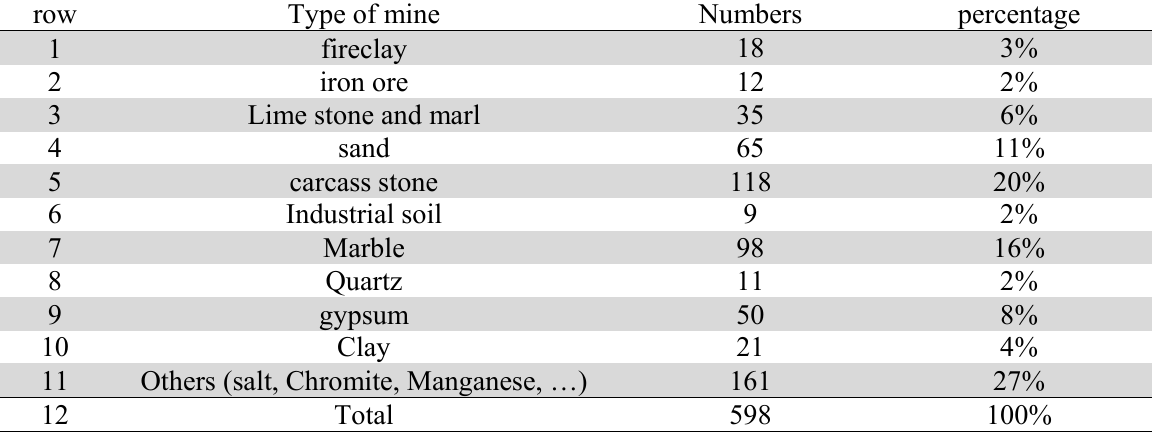
Statistics extracted from Iranian Mining Engineering Organization (IMEO) about Decorative stone mines